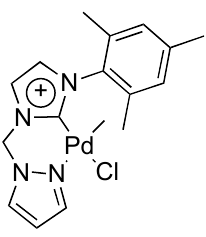
Figure 3. Palladium complex from N-pyrazolyl-N-aryl imidazolium based